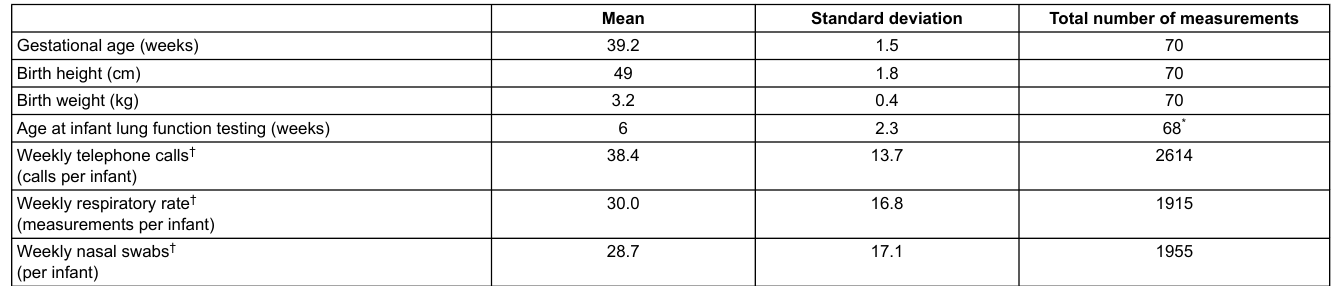
Table 2: Demographic details of the study population.